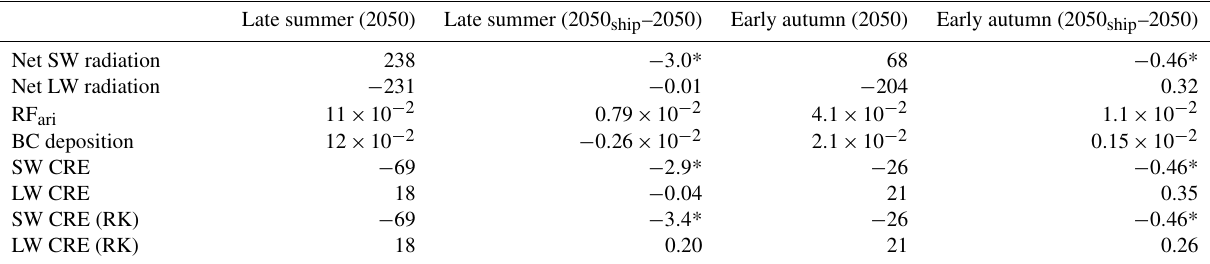
Figure 10. The impact of additional future ship emissions (arctic_2050_shipping versus arctic_2050) on aerosol number size distributions; N stands for the number concentration (assuming that 1kg air ≈ 1m 3 ), r ap for the radius of the aerosol particles. The size distributions are shown for early autumn (September–October) at 950hPa (a) and 800hPa (b) , averaged between 75 and 90 ◦ N. The solid lines denote ensemble means, the dotted lines the subtracted/added standard deviations. Different colours (black, green) stand for different simulations (see legend). Table 6. As Table 4 but for arctic_2050 (absolute values) and arctic_2050_shipping–arctic_2050 (differences) averaged over all latitudes north of 60 ◦ N in late summer (July–August) and early autumn (September–October). The arctic_2050_shipping–arctic_2050 simulation considers the impact of an increase in future Arctic ship emissions in